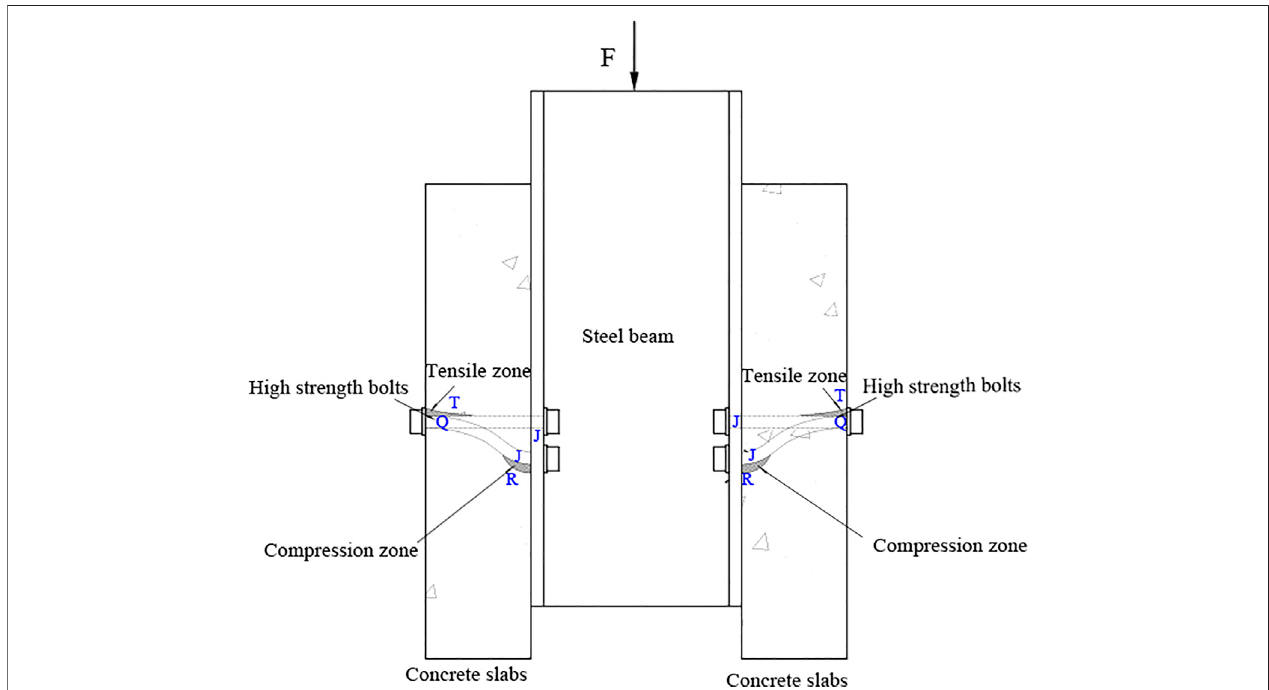
FIGURE 8 | Schematic diagram of the critical areas of HSFGBs and concrete